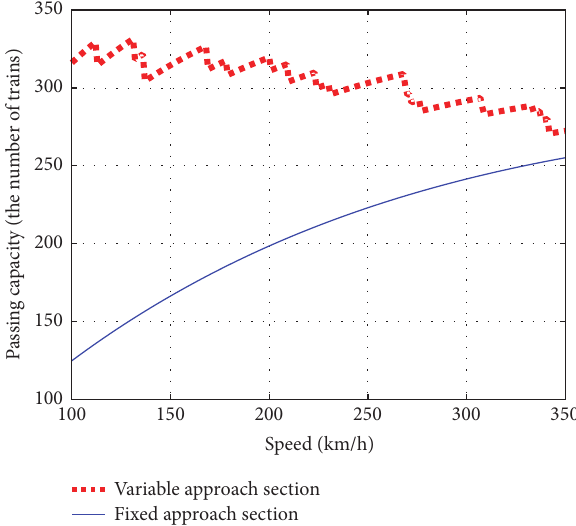
Figure 8: The comparison of passing capacity in both conditions.